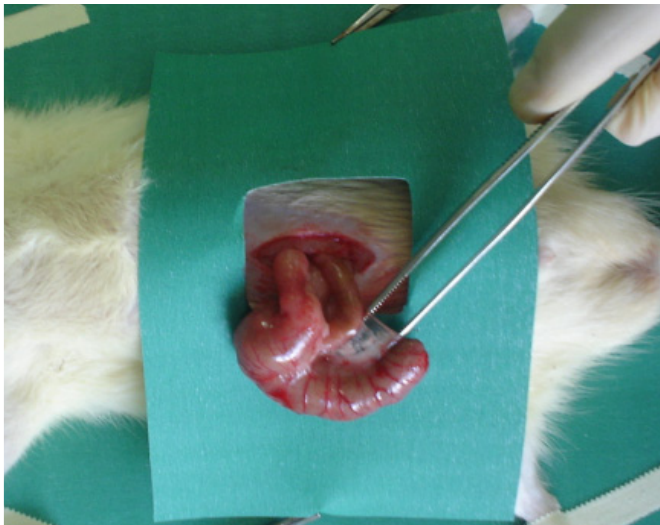
FIGURE 2 - Laparotomy incision and exposure of the intestinal viscera